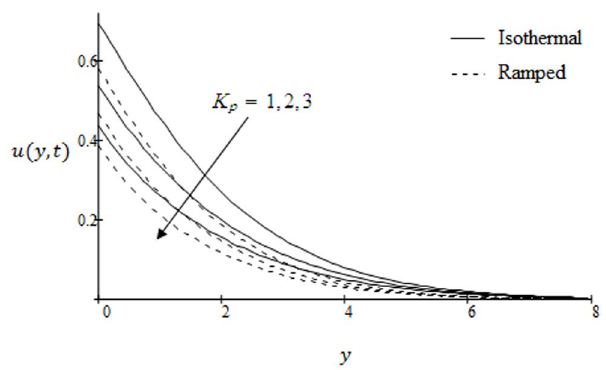
Figure 7. Velocity profiles for different values of K p when the plate applies a constant shear stress f ~{ 0 : 25 .